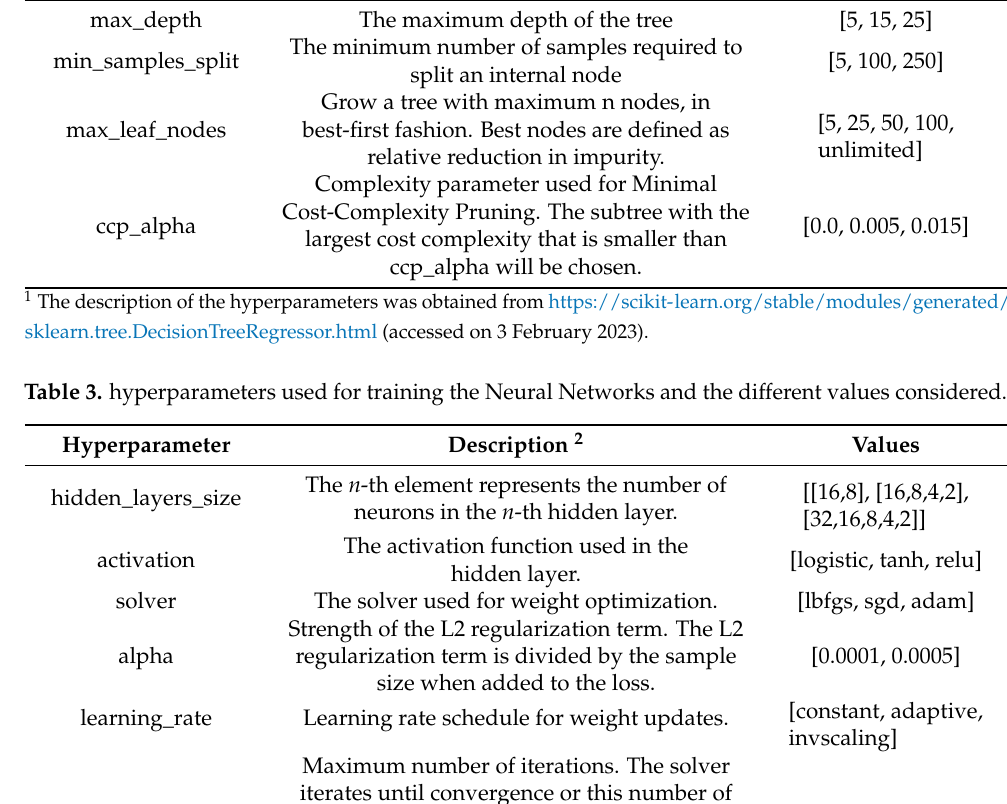
Table 2. hyperparameters used for training the Decision Trees and the different values considered. Hyperparameter